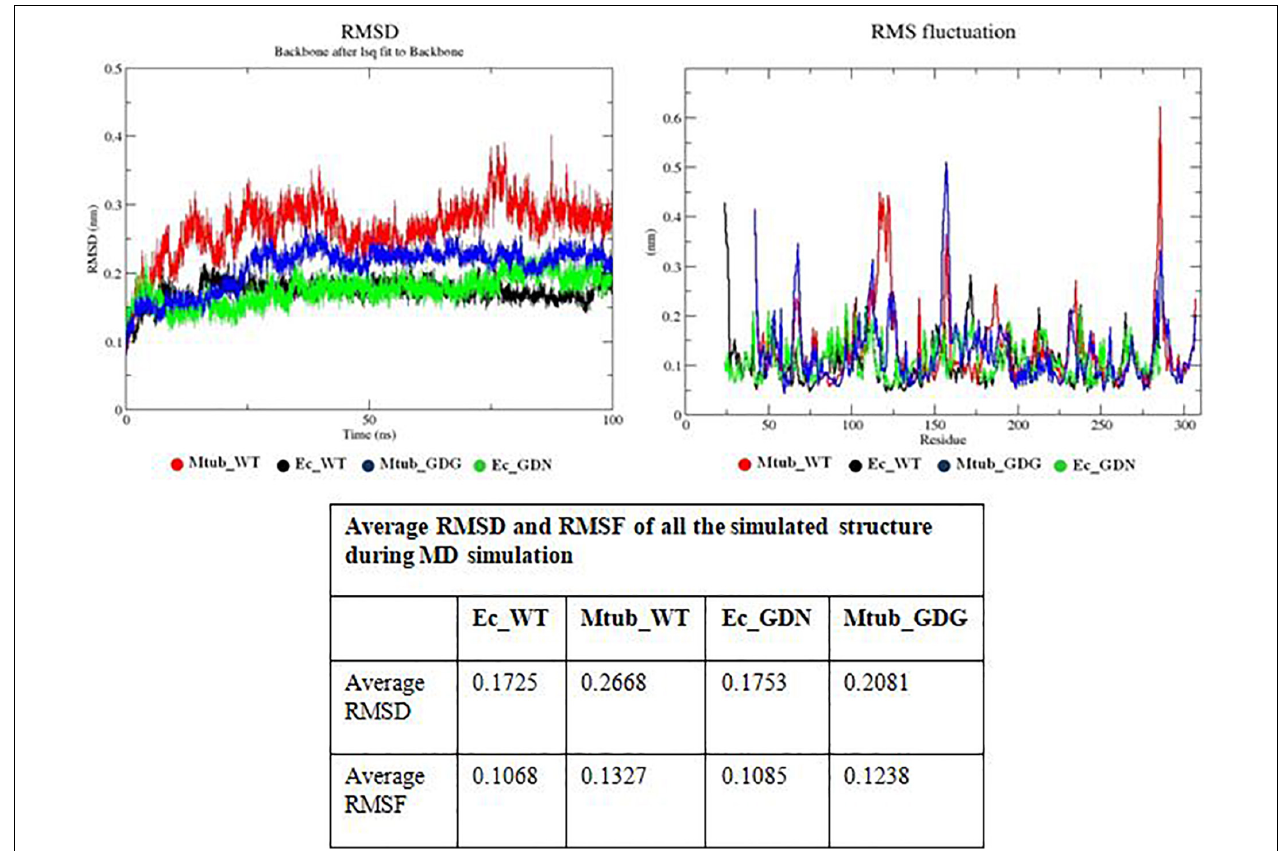
FIGURE 3 | Molecular dynamics simulation finding. The top panel describes RMSD analysis of wild-type BlaC, wild-type TEM, S130G mutant of BlaC, and S130G mutant of TEM. All the respective systems were designated with a particular color in the figure. The bottom panel describes the RMSF analysis of all the above systems. The bottom table indicates the average RMSD and RMSF values of all the simulated systems. RMSD, root mean square deviation; RMSF, root mean square